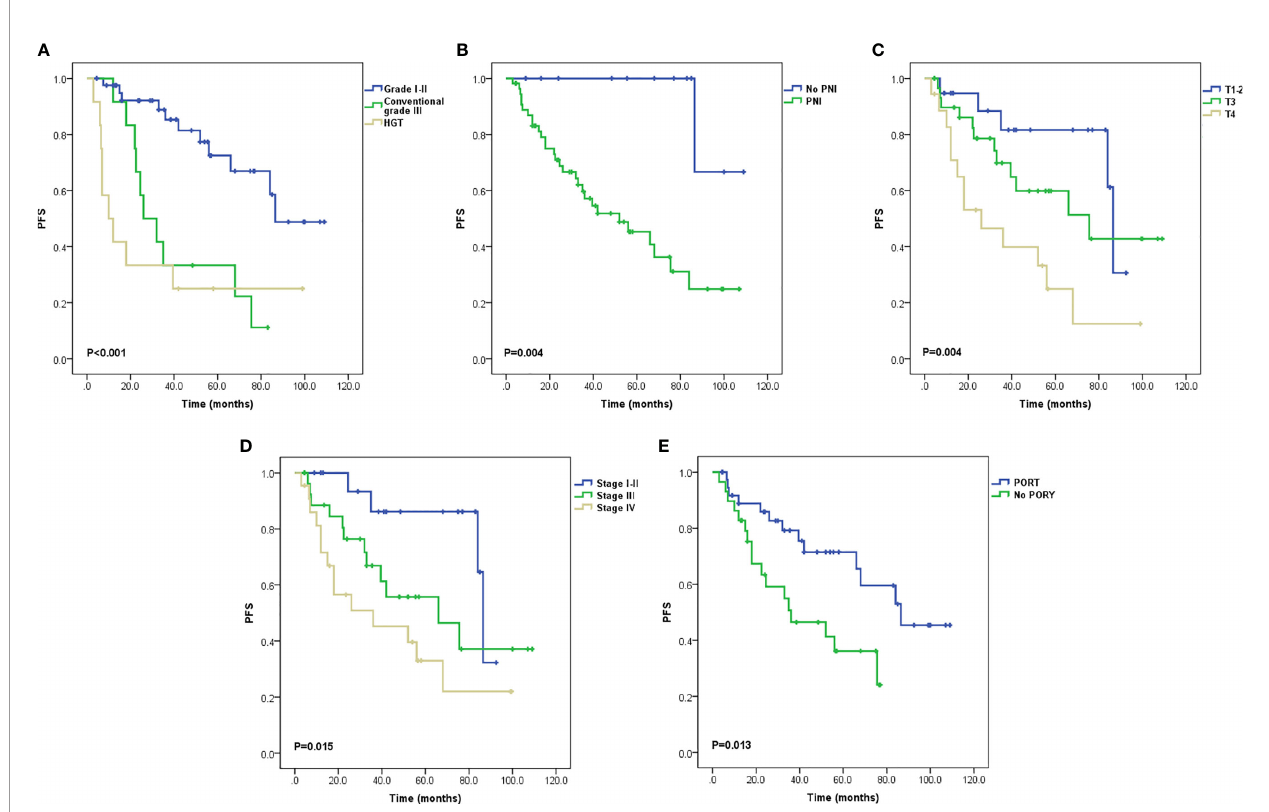
FIGURE 2 | Survival curves for progression-free survival (PFS) (A) Tumor grading, (B) Perineural invasion (PNI), (C) T stage, (D) Stage groups, and (E) Postoperative radiotherapy